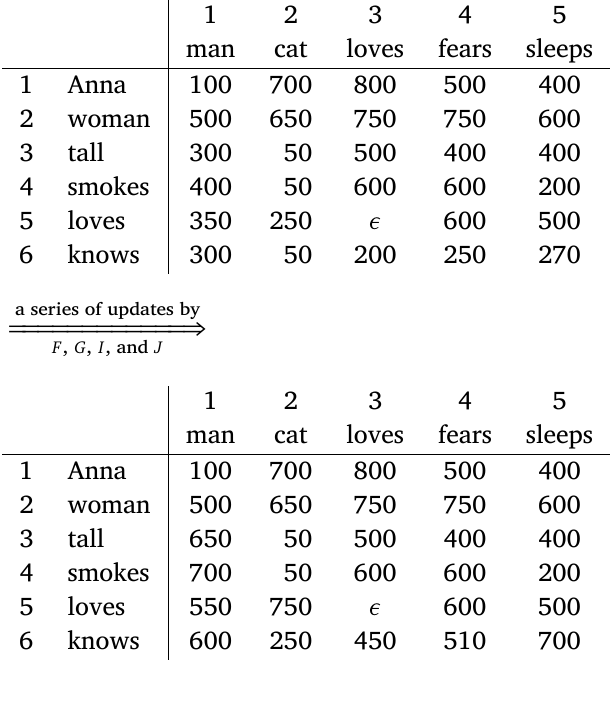
Figure 1: An example of updates by functions F , G , I , J on a co-occurrence